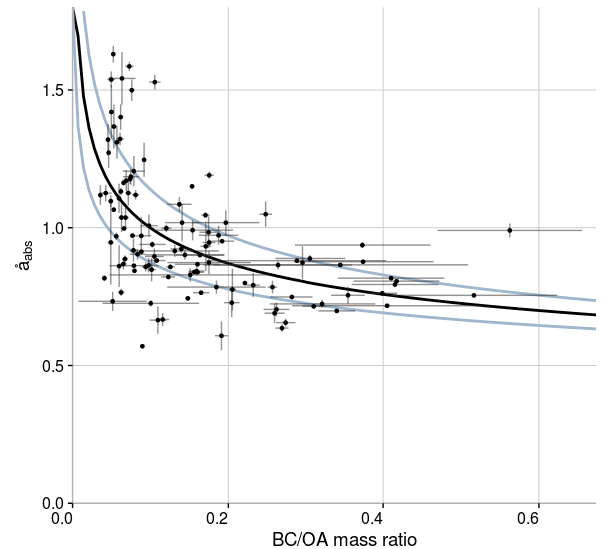
Figure 11. Absorption Ångström exponent ( å abs ) as a function of the BC / OA mass ratio for selected dust events in the wet season. The black line corresponds to a non-linear least squares fit applied to the data ( y = x − 0 . 199 × 0 . 632). The light blue lines correspond to the standard error of the